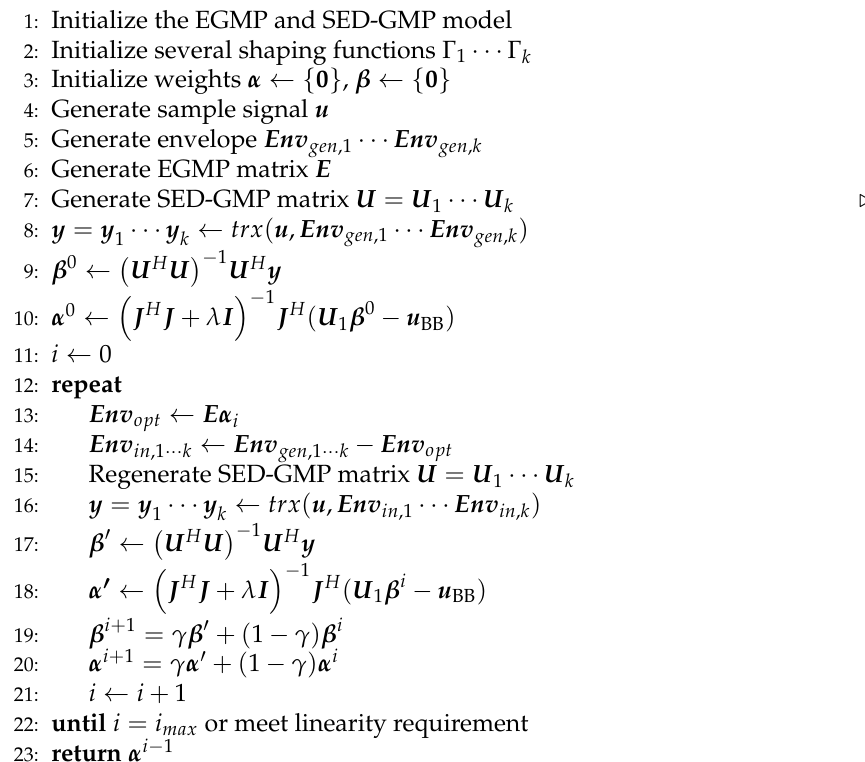
Algorithm 1 Adaptation procedure for